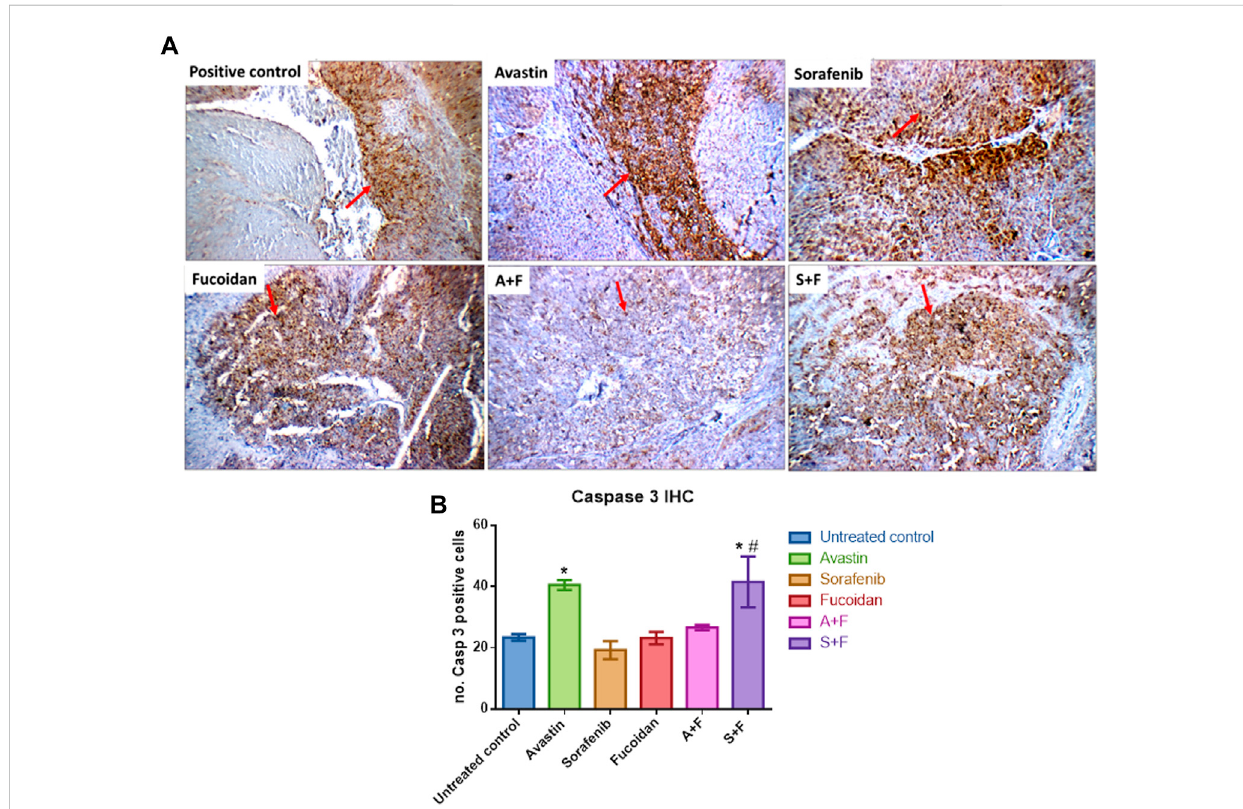
FIGURE 13 Immunohistochemistry analysis of caspase 3 (red arrows) in tumor nodules within liver tissues. (A) Photomicrographs of livers extracted from rats treated with the different drugs. Positive control liver view showing moderate cytoplasmic reactivity (++) for caspase 3. Avastin treated liver tissue showing marked cytoplasmic reactivity (+++). Sorafenib treated liver showing moderate cytoplasmic reactivity (++). Fucoidan and A + F showing moderatecytoplasmicreactivity(++)forcaspase-3intumortissue and fi nallyS+Flivershowingmarkedcytoplasmicreactivity(+++)for caspase-3 in tumor tissue. (Caspase 3 immunostaining (red arrows) and Hematoxylin counterstain, x 200). (B) Number of caspase 3 positive cells showing that the combination of S + F was signi fi cantly better than sorafenib alone, but an opposite pattern was observed for Avastin. Avastin monotherapy showed signi fi cantly higher levels of caspase 3. (n = 3 – 5, * p < 0.05 versus untreated control, # p < 0.05 versus monotherapies, one-way-ANOVA with Tukey ’ s post hoc